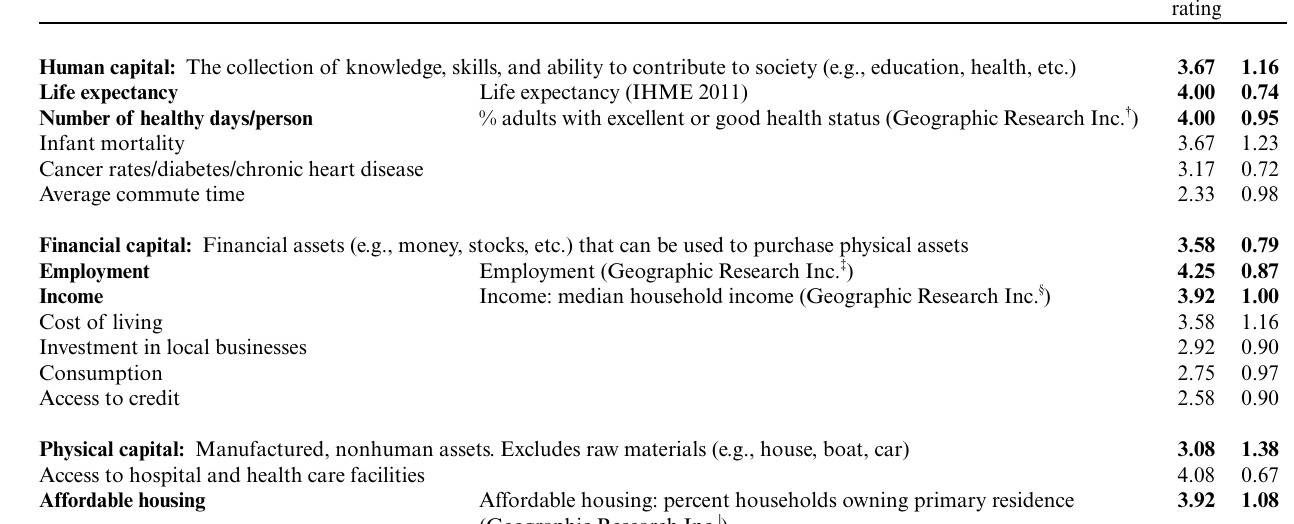
Table 4 . Participants rated the importance of capitals to their overall well-being and potential indicators to their respective capital asset on a scale of 1-5, with 5 suggesting the strongest contribution to well-being. Each capital and indicator was ranked independently (i. e., more than one capital or indicator could share a rating) and averaged for all participants (n = 12). Indicators included in this assessment are noted in